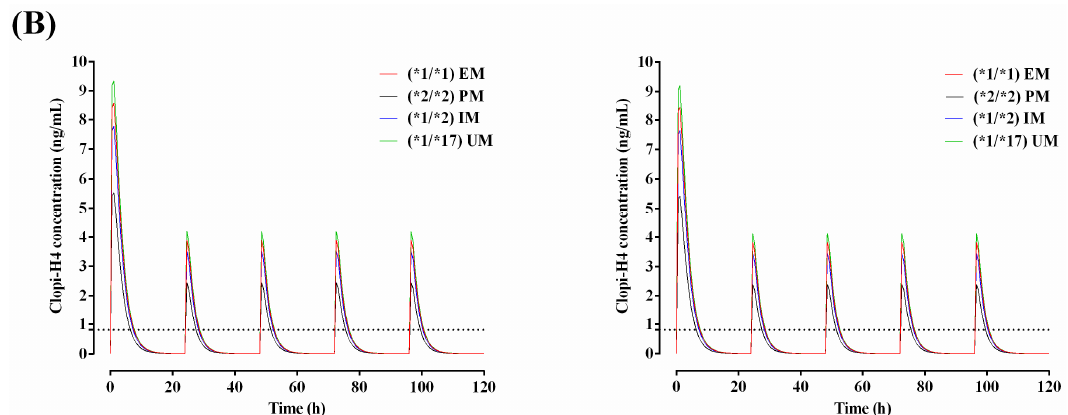
Figure 10. ( A ) impact of clopidogrel standard dose regimens on final dose clopi-H4 plasma C max (upper panels) and C min (lower panels) in Malay (left panels) and Malaysian Chinese (right panels) subjects, demarked for all EM, PM, IM or UM populations. Box and whisker plots represent maximum, 75th percentile, median, 25th percentile and minimum clopi-H4 C max ; ( B ) simulated mean plasma concentration–time profile of clopi-H4 in Malay (left panel) and Malaysian Chinese (right panel) subjects demarked for all EM, PM, IM or UM populations. All subjects ( n = 100 for each phenotype) received a loading dose of 300 mg on day 1, followed by daily doses of 75 mg for four days. Solid lines represent mean plasma concentration–time predictions. Dashed horizontal lines represent the lower therapeutic limit for clopi-H4.